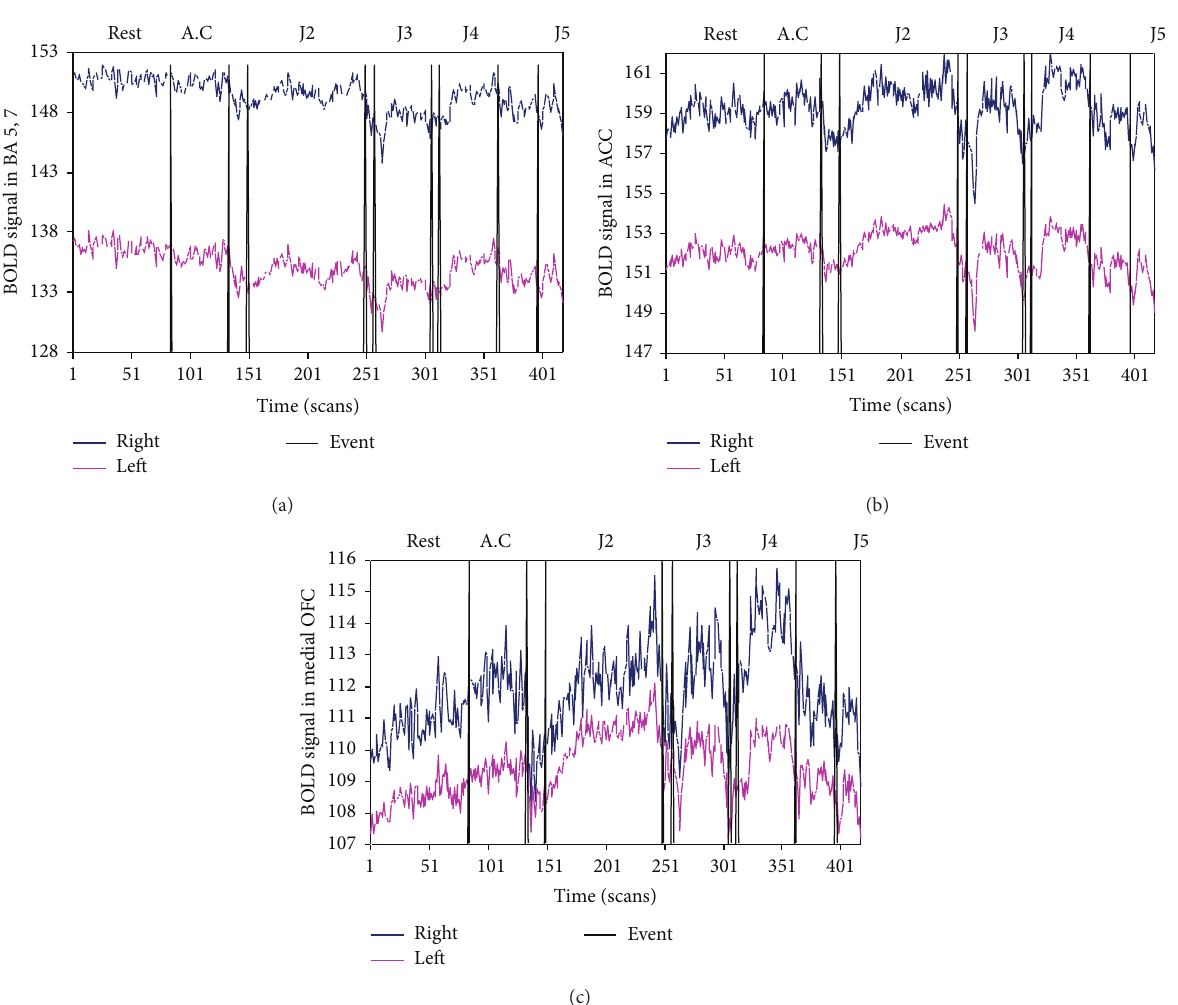
Figure 4: Time course (in fMRI scans) of BOLD signal for three a priori defined ROIs (blue line shows right side of ROI, and red line shows right side) graphing transitions between rest, access concentration, and jhanas. Figure 4(a) shows BOLD signal averaged for all voxels in BA 5 and 7 (orientation area), Figure 4(b) shows average BOLD in ACC, and Figure 4(c) shows average BOLD in medial OFC. Note the prompt drop in signal during transition events, including the decline in BA 5,7 activity during jhanas and the increase in OFC signal during jhanas (J1 was not recorded due to head movement